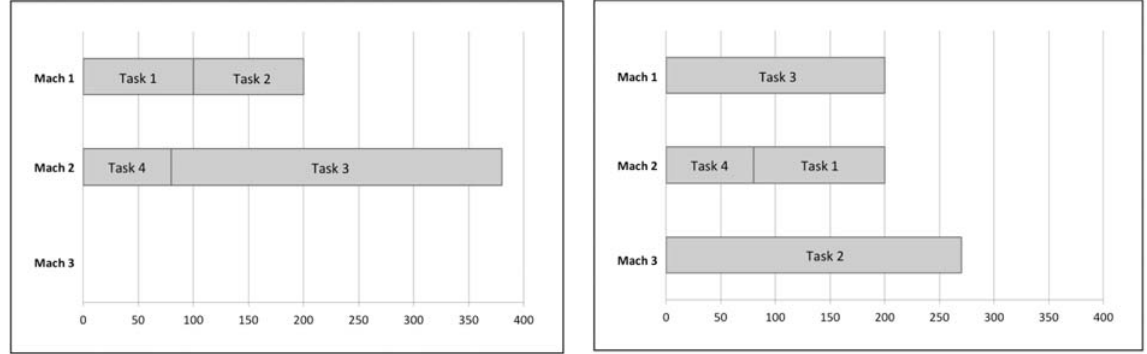
Fig. 3. Min-Min Solution Fig. 4. Suffrage